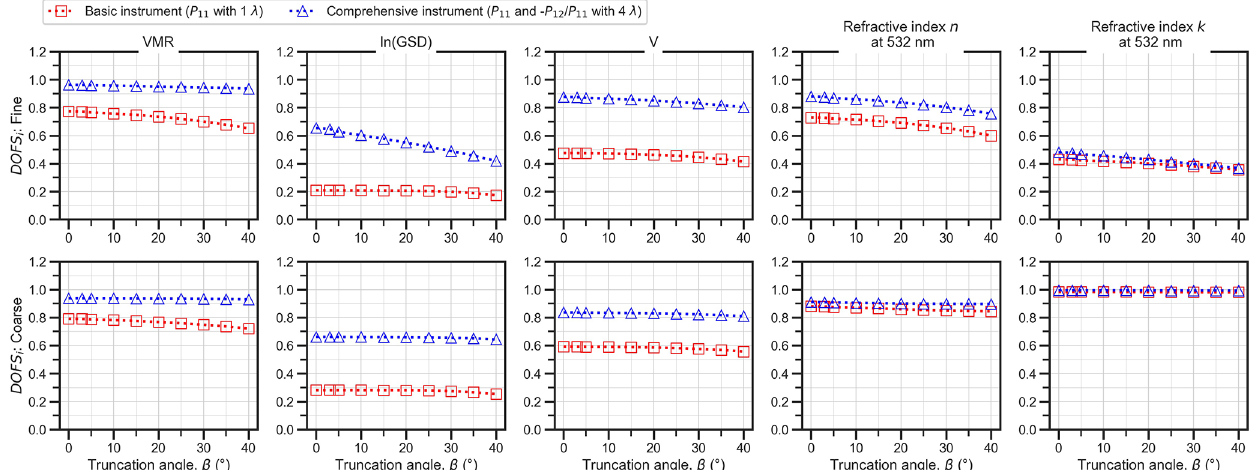
Figure 8. Variation in DOFS i for unimodal, non-absorbing-aerosol test cases over different side-truncation angles. The top row demonstrates the results for the fine-aerosol test case, while the bottom row corresponds to results for the coarse-aerosol test case. These results were obtained using default measurement noise values and the “high level of prior knowledge” method for selecting a priori variances.